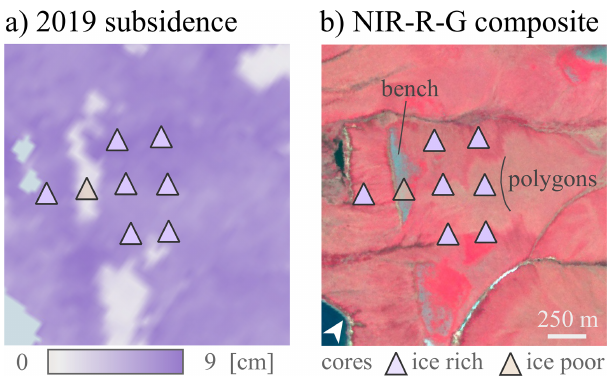
Figure 9. Late-season subsidence in 2019 (a) at the Tatchim Isua site (see Fig. 5 for its location) is smaller at the site of the gravelly bench, which appears grey in the false-colour composite (courtesy of Planet Labs, Inc.; Planet Team, 2020) in (b) than the areas further upslope (right) and downslope (left). The triangles mark the loca- tion of the ice cores, with the colour indicating their ice content. Ice wedge polygons were observed in the field ∼ 300m upslope from the